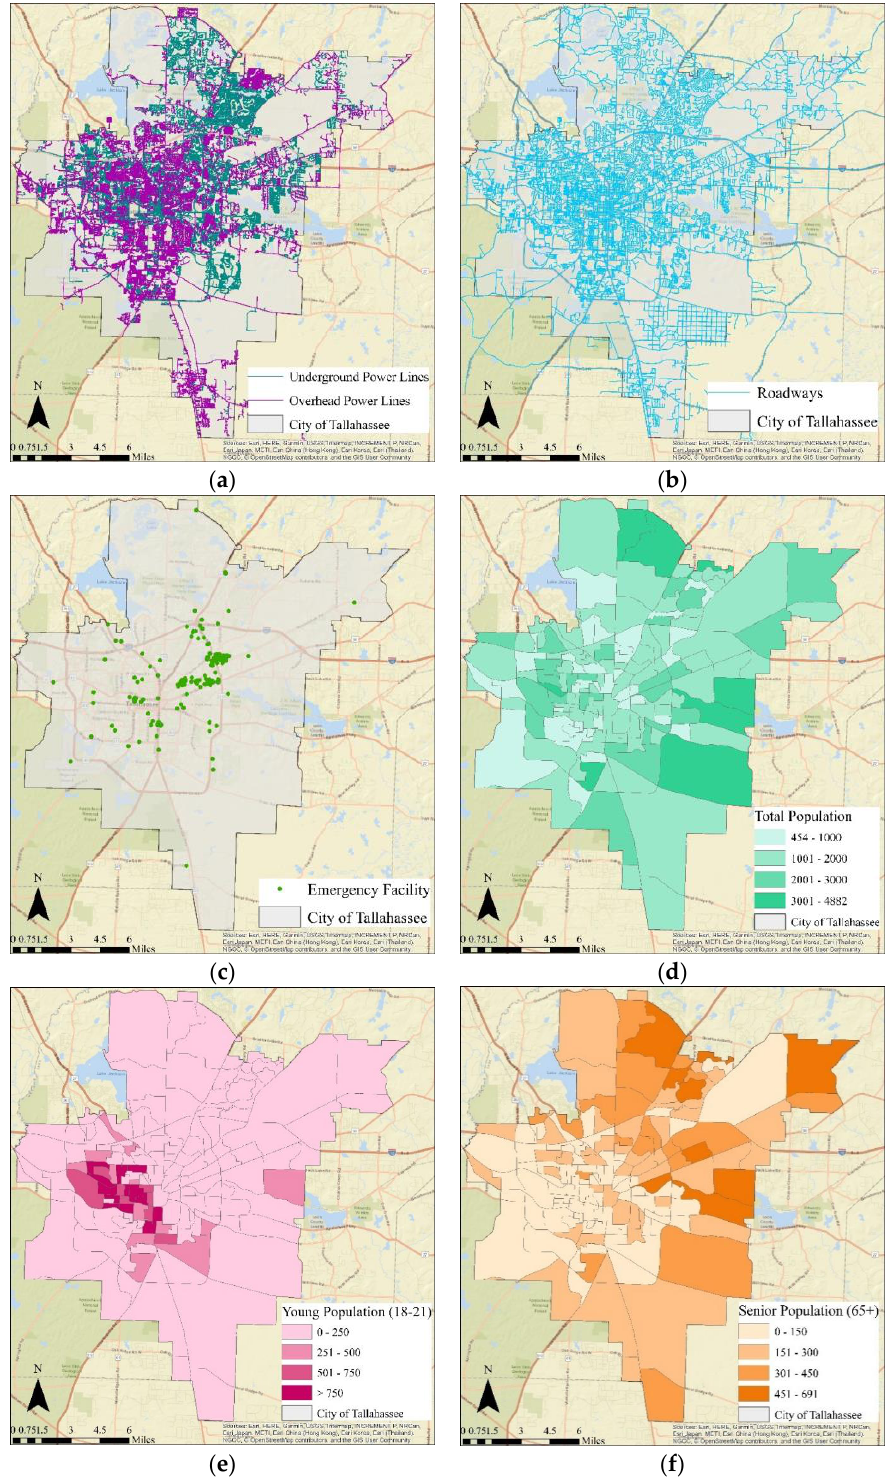
Figure 3. Power network (a) ; roadway network (b) ; spatial distribution of facilities (c) ; total population (d) ; young population (18-21) (e) ; senior population (65+) (f) .